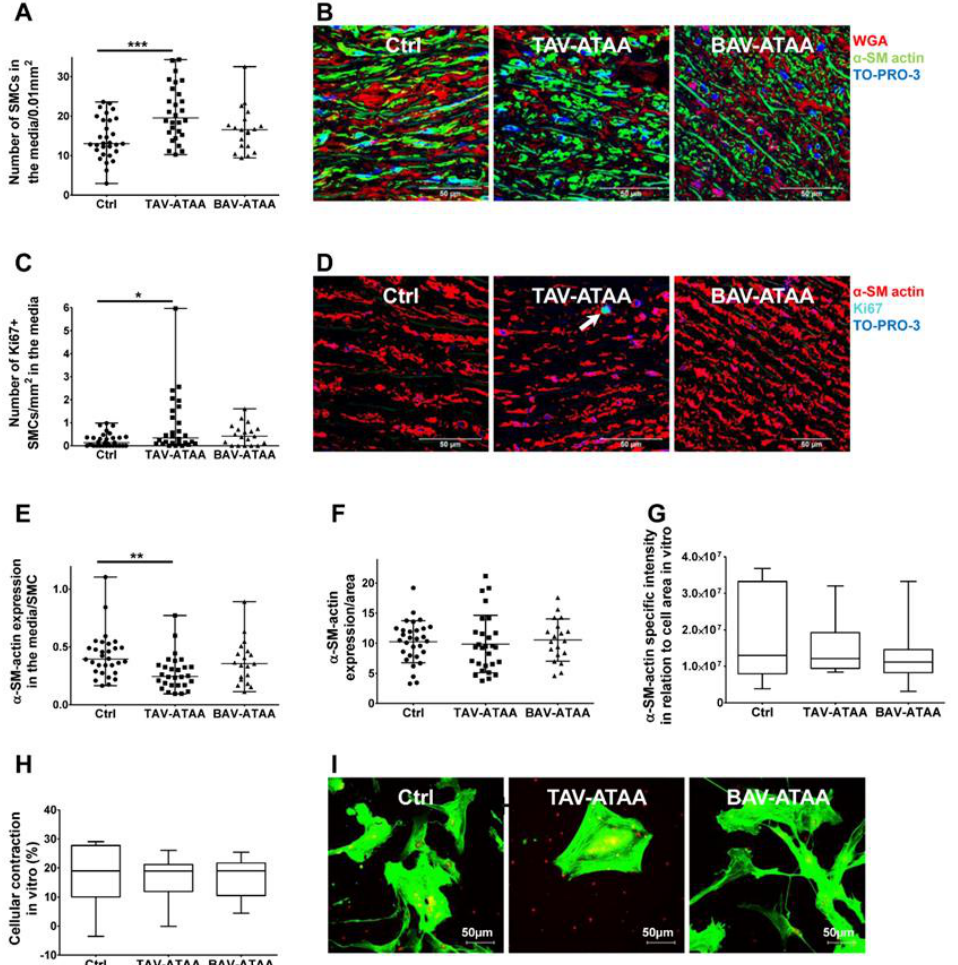
Figure 5. TAV-associated increase in smooth muscle cell density and decrease in α -SM actin expression per smooth muscle cell in situ. ( A ) shows the results of the quantification of smooth muscle cell density in aneurysmal and control media tissue specimens. In ( B ) representative images of aortic tissues following immunofluorescence based detection: wheat germ agglutinin (WGA, cell surface, red), α -SM actin (green), and cell nuclei (TO-PRO-3, blue) are shown. Magnification of images is 63x. In ( C ) the quantification of the amount of Ki67 positive smooth muscle cells is depicted with corresponding representative images shown in ( D ). Magnification of images taken is 63×. ( E ) shows the quantification of α -SM actin expression per smooth muscle cell within the aortic media. (Control n = 30; TAV n = 28; BAV n = 19) In ( F ), the quantification of α -SM actin expression per medial area is shown. (Control n = 30; TAV n = 28; BAV n = 19) In correspondence, ( G ) gives the quantification of the expression of α -SM actin within the isolated smooth muscle cell-lines in vitro . ( H ) shows the results of the quantification of smooth muscle cell-contraction (% of the length of relaxed cells in relation to cell area) ability in response to carbamylcholine chloride in vitro. (Control n = 9; TAV n = 10; BAV n = 10) ( I ) shows representative images of isolated smooth muscle cells stained for α -SM actin (magnification 60 × ). (** <